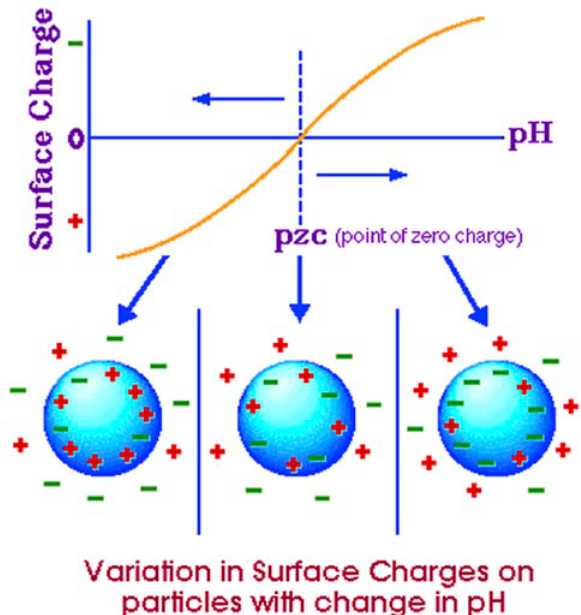
Figure 6. The general form of the curve of potential energy is plotted as a function of particle separation (interparticle distance or concentration of the paste) for interaction between particles in a colloidal system. V r and V a are repulsive and attractive energies respectively and the curve represents their sum at a given interpar- ticle distance. This is characteristic of sediment particle interactions. The general behaviour of particles at various distances from each other is indicated at the top of the diagram. Note the critical inter- particle separation at which accretions begin to form. This curve describes the general behaviour of particles resulting from the inte- raction of these forces and is not specific to any particular type of colloidal particle. This succession of repulsion, strong attraction and resistance at exceedingly close proximity is called the DLVO theory that has now been confirmed by direct measurement with an adap- ted atomic force microscope.